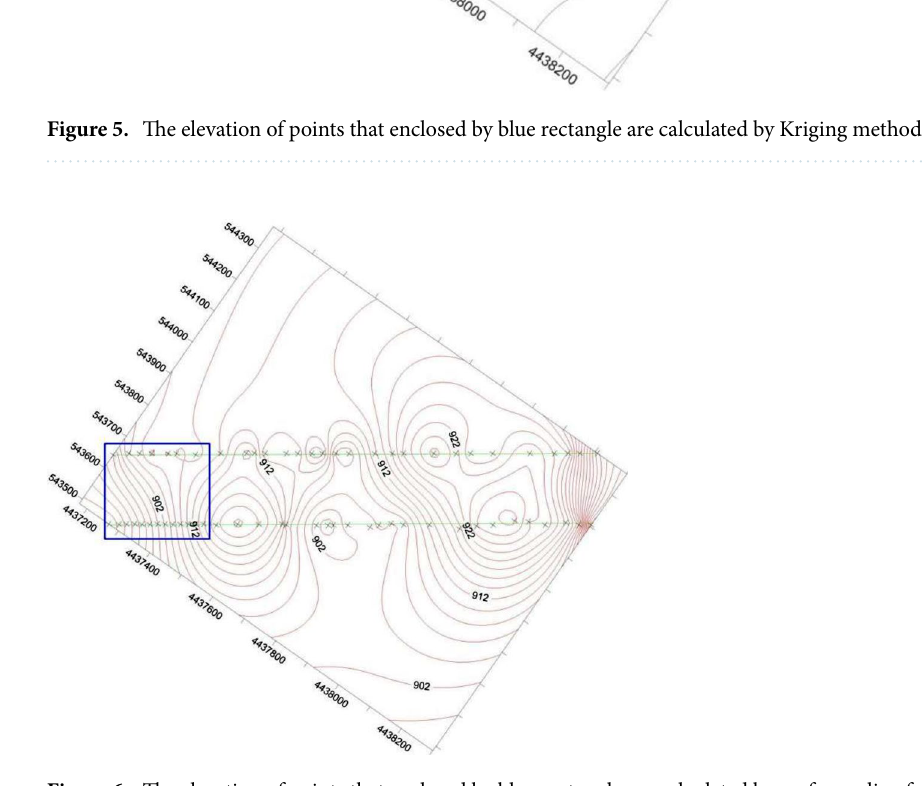
Figure 6. The elevation of points that enclosed by blue rectangle are calculated by surface spline